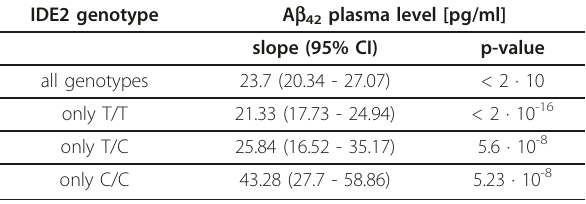
level is shown. Effect sizes and nominal p-values were derived from multivariate regression analysis with sex and presence of apolipoprotein